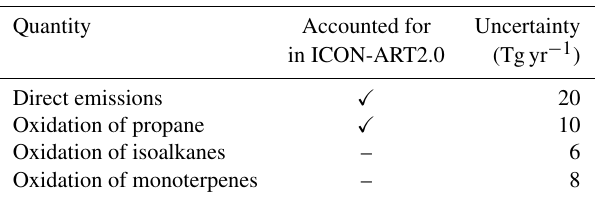
Table 7. Estimated uncertainty of acetone emissions and precursor species in Tg ( acetone ) yr − 1 . Quantity Accounted for Uncertainty in